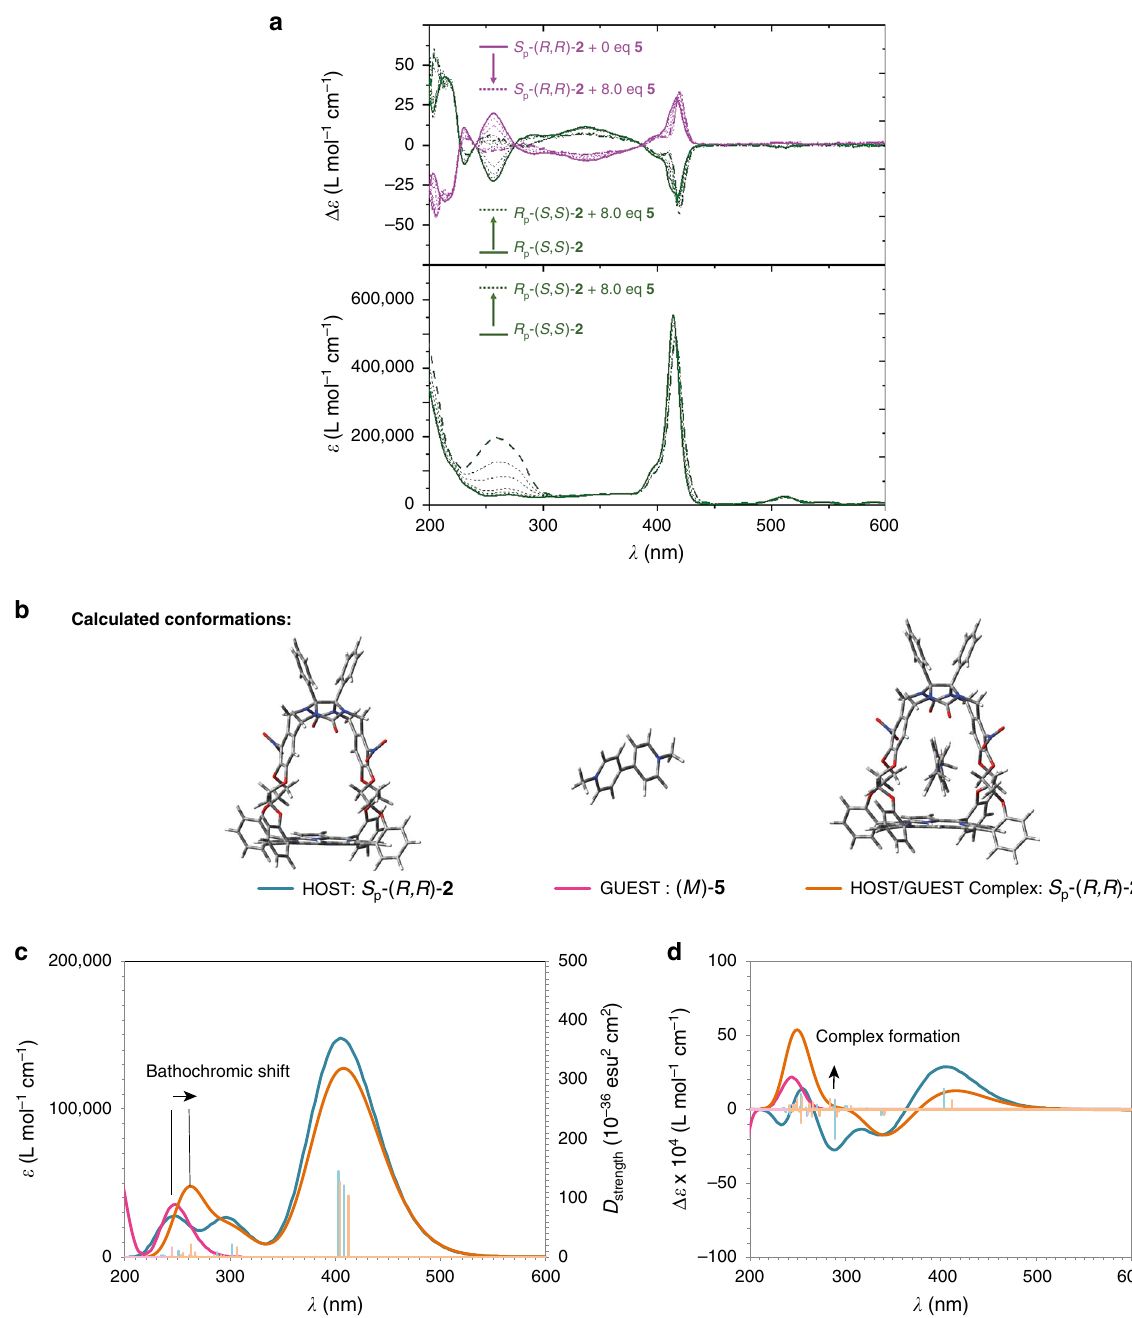
Fig. 5 ECD and UV-vis spectra of host – guest complexes. a ECD and UV-vis spectra of S p -( R , R )- 2 and R p -( S , S )- 2 (solvent acetonitrile, c = 7.5 × 10 − 5 M) upon addition of increasing amounts of guest 5 . b Calculated conformations of host S p -( R , R )- 2 , the ( M )-form of guest 5 , and the complex of this host and guest S p -( R , R )- 2 /( M )- 5 c . Calculated UV-vis and d calculated ECD spectra of the retained conformations of the host S p -( R , R )- 2 (blue line and blue bars: dipole (UV) and rotational (ECD) strengths), of the guest (M)- 5 (pink line and pink bars: dipole (UV) and rotational (ECD) strength), and of the complex S R , R )- 2 /( M )- 5 (orange line and orange bars: dipole (UV) and rotational (ECD) strengths). p -(